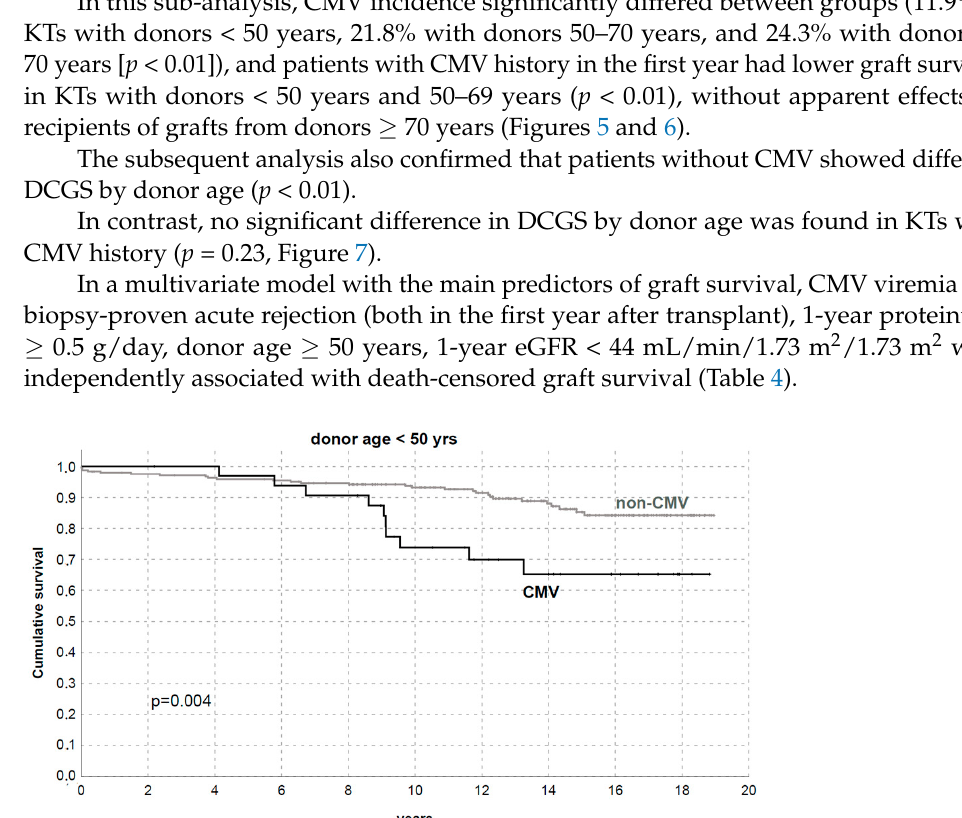
Figure 5. Death-censored graft survival by CMV replication/disease in the first year after transplantation with donors <50 years, 50–69 years, or ≥ 70 years.